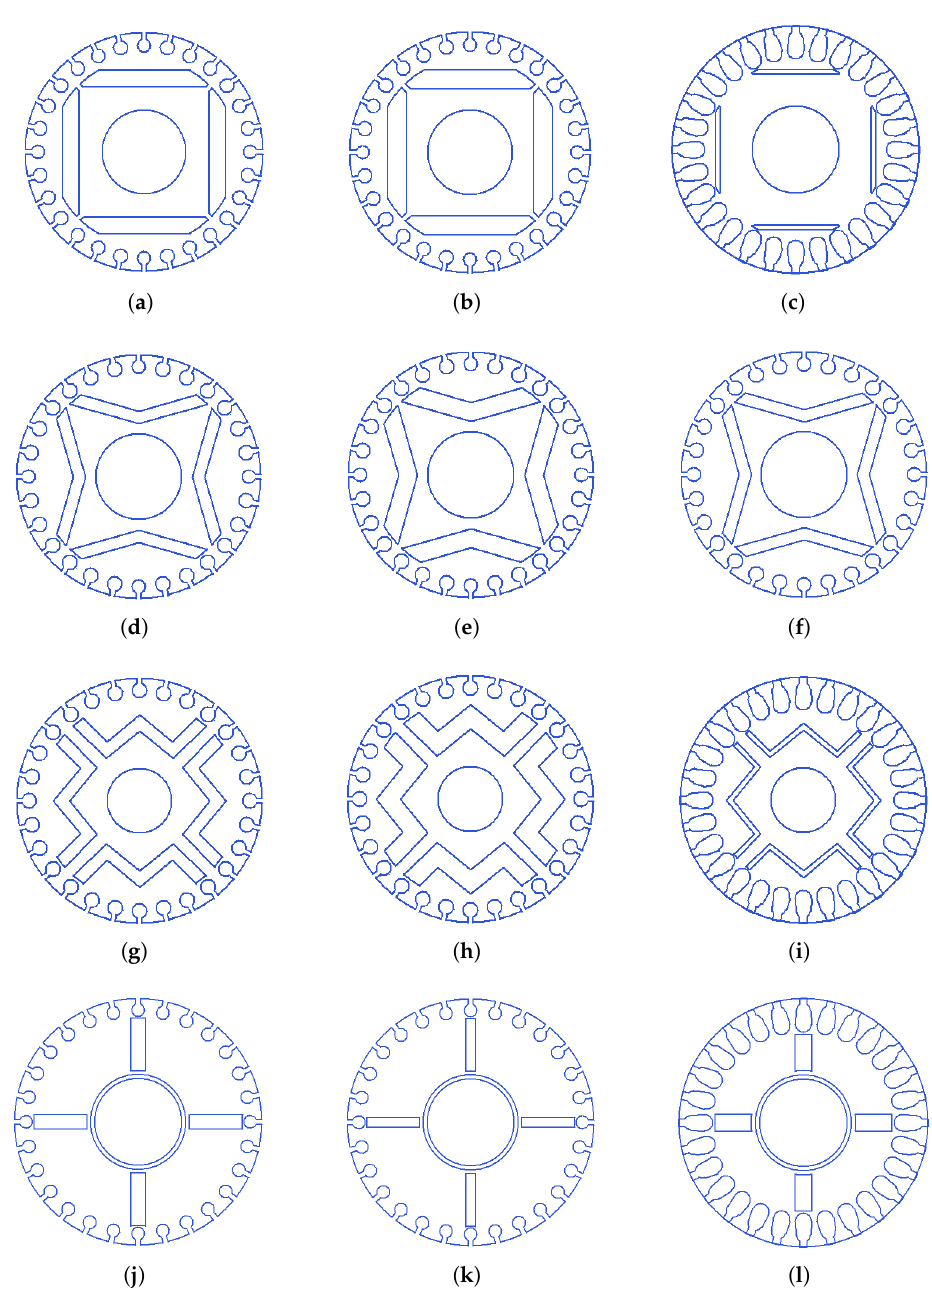
Figure A1. Test machine set rotor layouts: ( a ) Radial 1, ( b ) Radial 2, ( c ) Radial 3, ( d ) V-type 1, ( e ) V-type 2, ( f ) V-type 3, ( g ) W-type 1, ( h ) W-type 2, ( i ) W-type 3, ( j ) Spoke-type 1, ( k ) Spoke-type 2, ( l ) Spoke-type